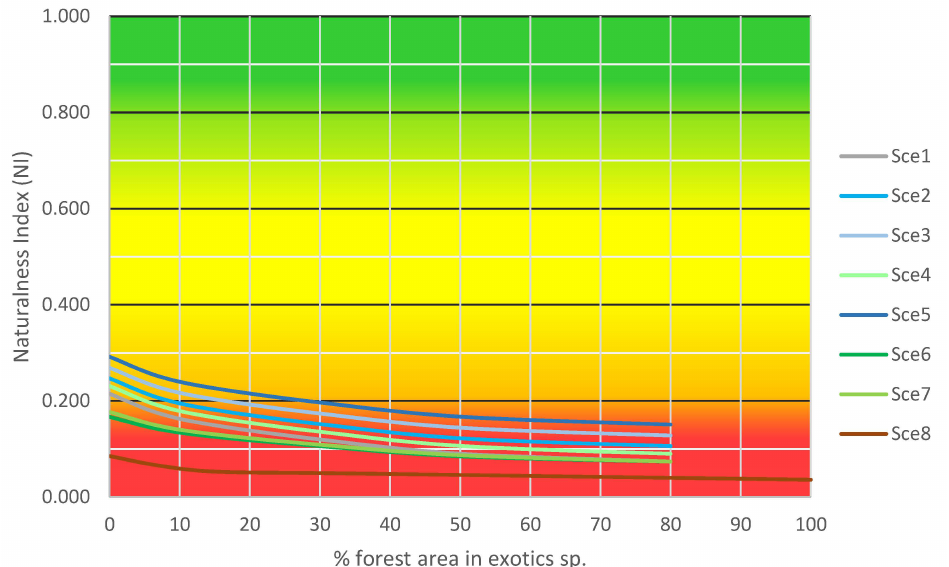
Figure 8. Results for the eight extreme scenarios. See also Table 7 for detailed scenario